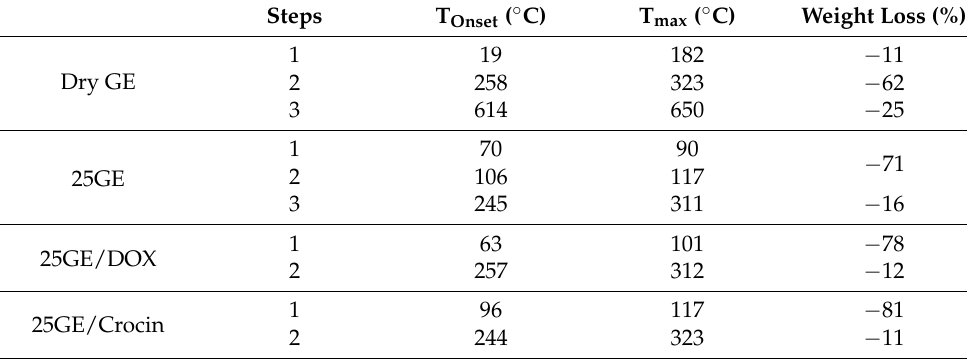
Table 4. Weight loss reason at the maximum peaks of temperature shown in Table 3.